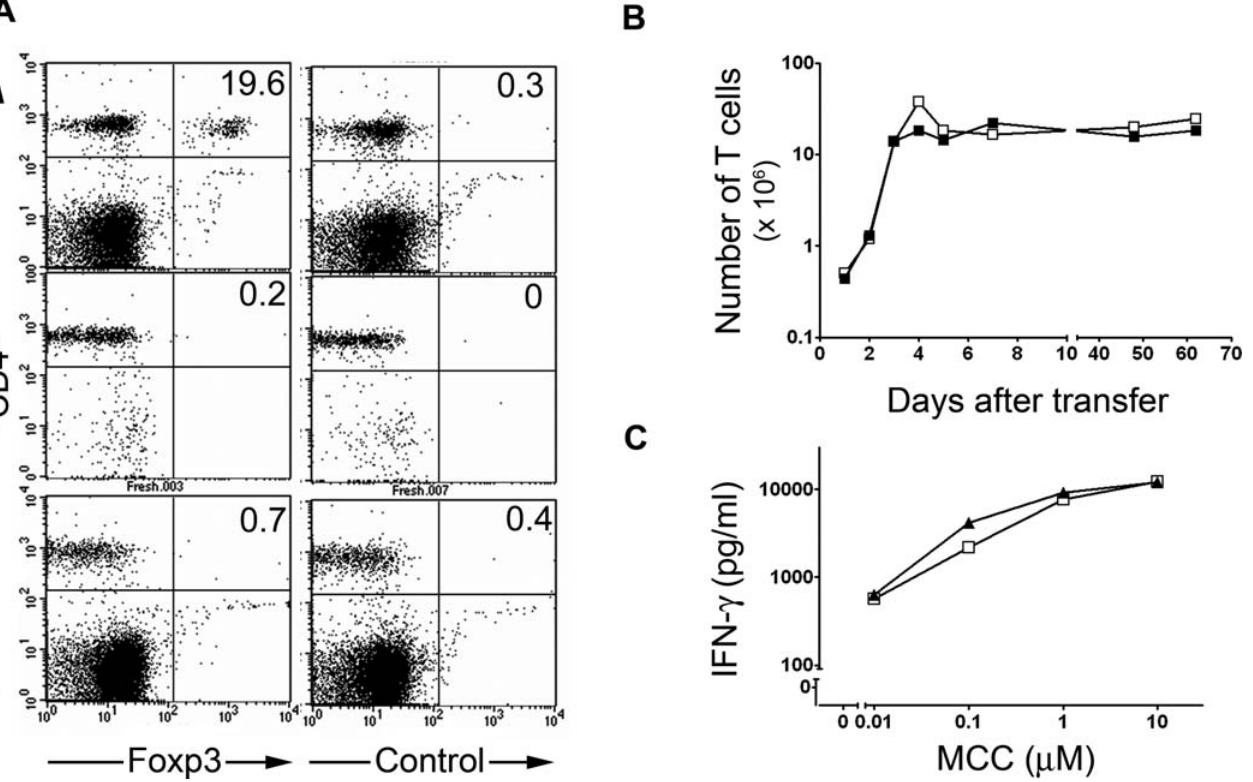
Figure 1. Adaptive Tolerance Can Be Induced Independently of Regulatory Activity (A) Intracellular staining with antibodies to foxp3 (left panels) or an isotype-matched control (right panels) on naive 5C.C7 T cells (middle two panels) or antigen-adapted T cells (bottom two panels). Positive control staining in a polyclonal population of B10.A T cells marks approximately 19% of the CD4 þ T cells (top two panels). (B) A new cohort of naive 5C.C7 T cells expands similarly in B10.A, PCC þ / þ , CD3 e (cid:1) / (cid:1) hosts (open squares) even if they already harbor expanded 5C.C7 T cells (solid squares). Newly transferred 5C.C7 T cells were distinguished from the previous population using congenic markers (Ly5.1). (C) Congenically marked Ly5.1 þ / þ ,5C.C7 T cells that expanded in a naive B10.A, PCC þ / þ , CD3 e (cid:1) / (cid:1) host (open squares) or a PCC þ / þ , CD3 e (cid:1) / (cid:1) host that had been injected with Ly5.2 þ / þ ,5C.C7 T cells 28 d in advance (solid squares) were purified by FACS sorting (Ly5.1 þ , CD4 þ ) and restimulated in vitro